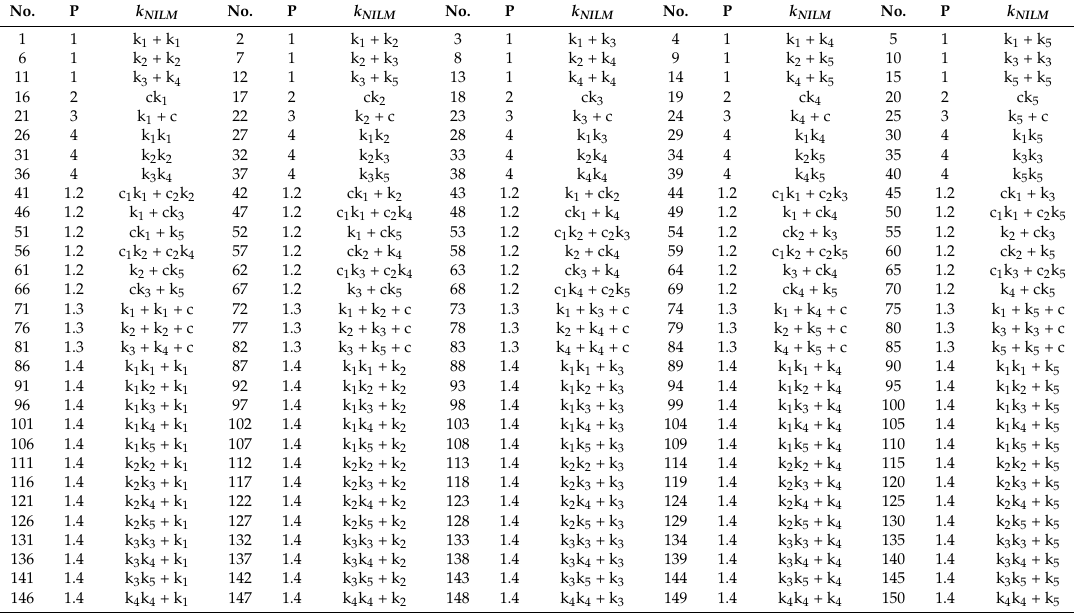
Table A1. Scenario setting for k NILM using properties 1–4 with typical